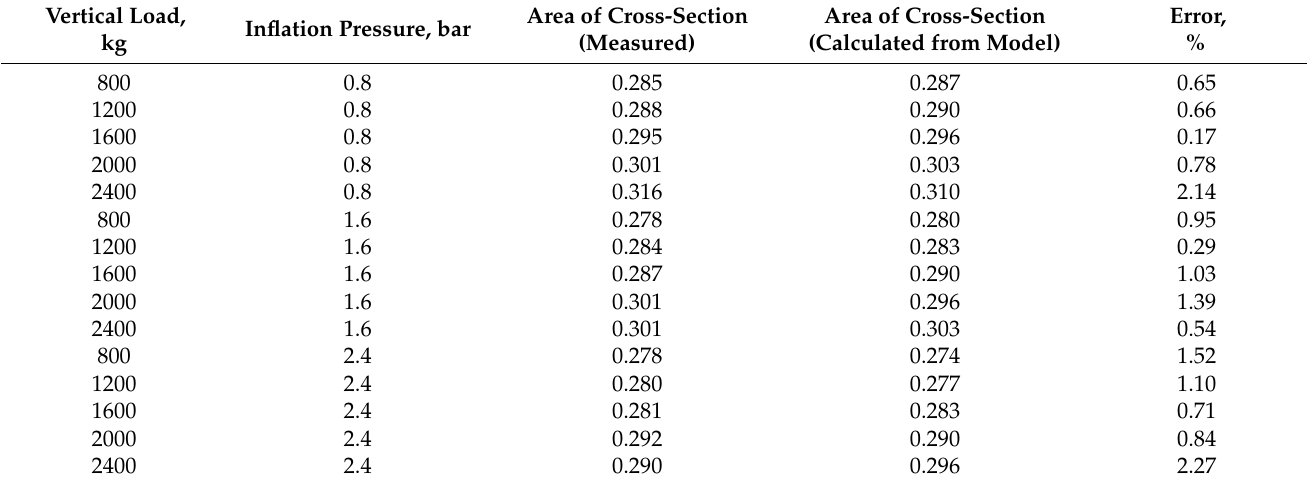
Table 7. Verification of mathematical model for bias-ply